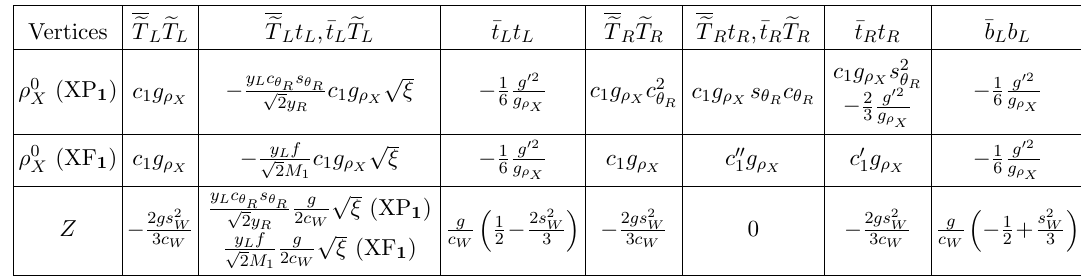
Table 4. The LO coupling strengths between the neutral spin-1 gauge bosons, (cid:26) 0 fermions in models XP(F) 1